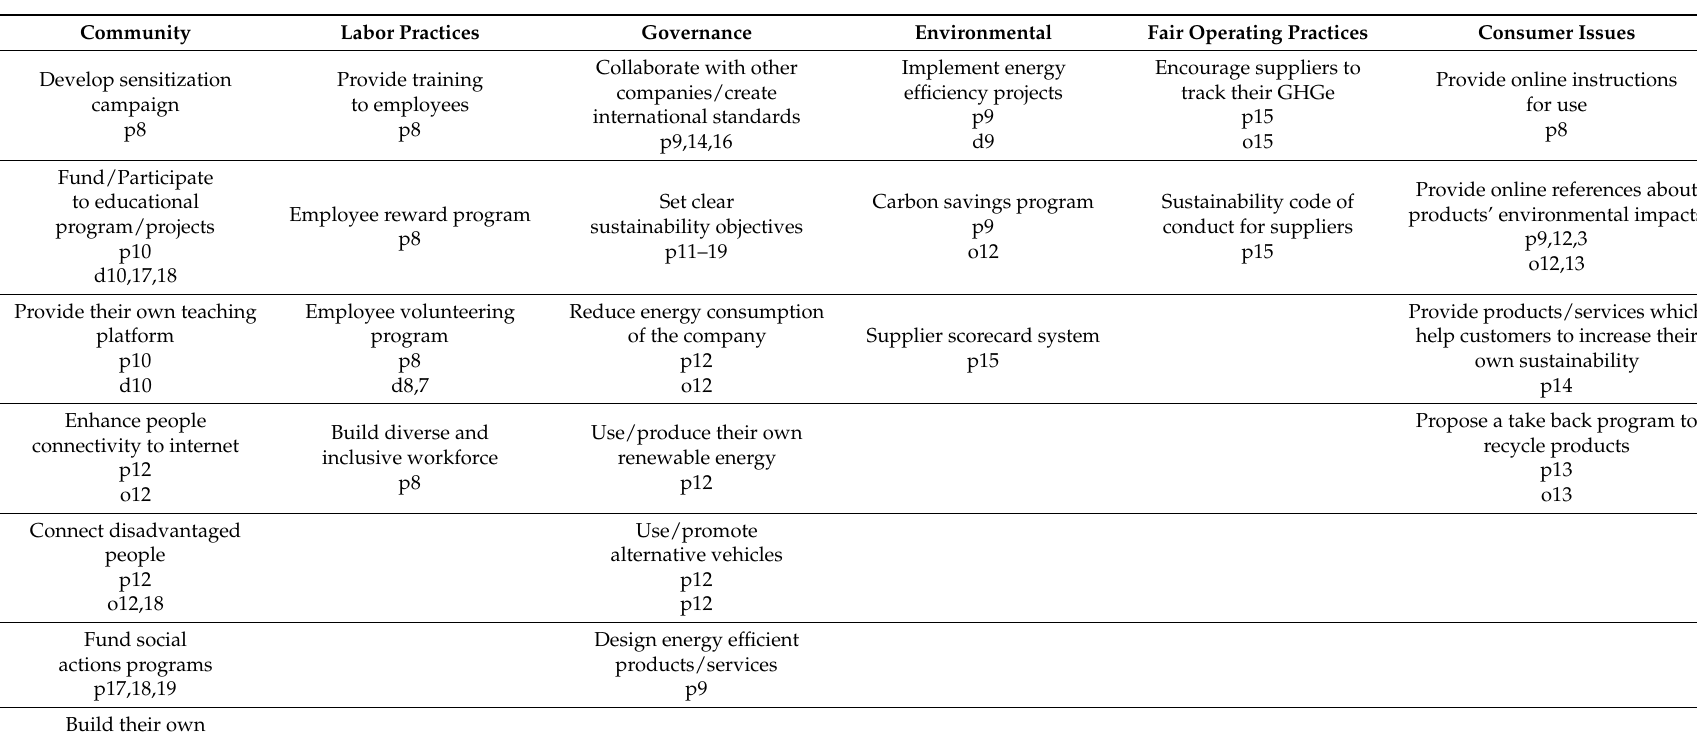
Table 2. Example of the strategy referencing of AT&T’s CSR report using the ISO 26000 criteria (This report didn’t mention any strategy about human rights this is why the category does not appear in the